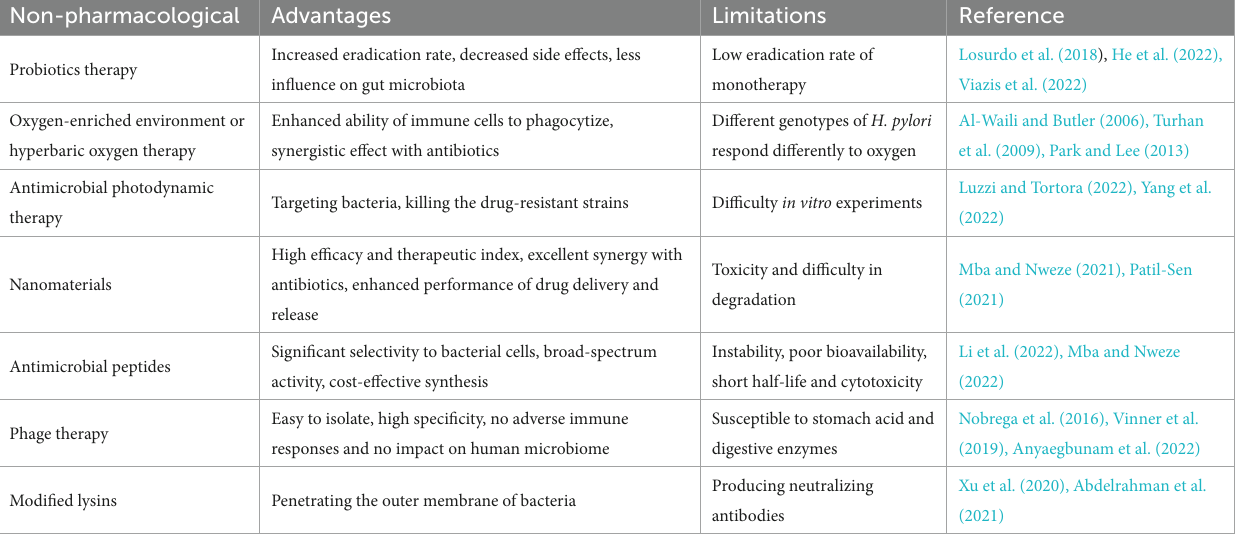
TABLE 2 Advantages and limitations for the non-pharmacological treatment of Helicobacter pylori .